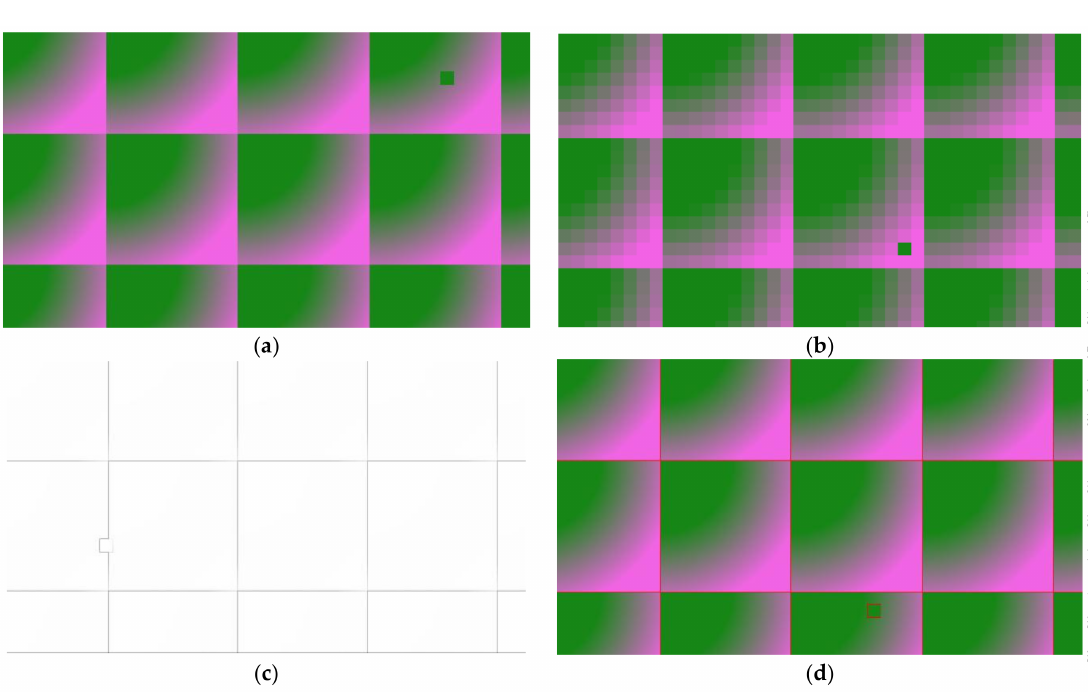
Figure 1. The three hardware filters working on an instance of the video stream generated by the TGP block: ( a ) original video, ( b ) posterize, ( c ) Sobel operator, and ( d ) FAST. Note the small green square object moving throughout the